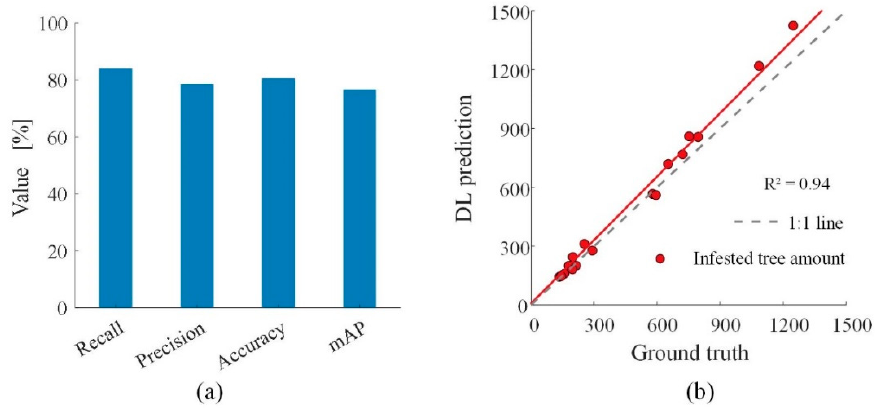
Figure 4. Assessment of deep-learning (DL)-based infested tree detection. ( a ) accuracy metrics; ( b ) comparison of infested tree amount between DL-prediction and ground truth.